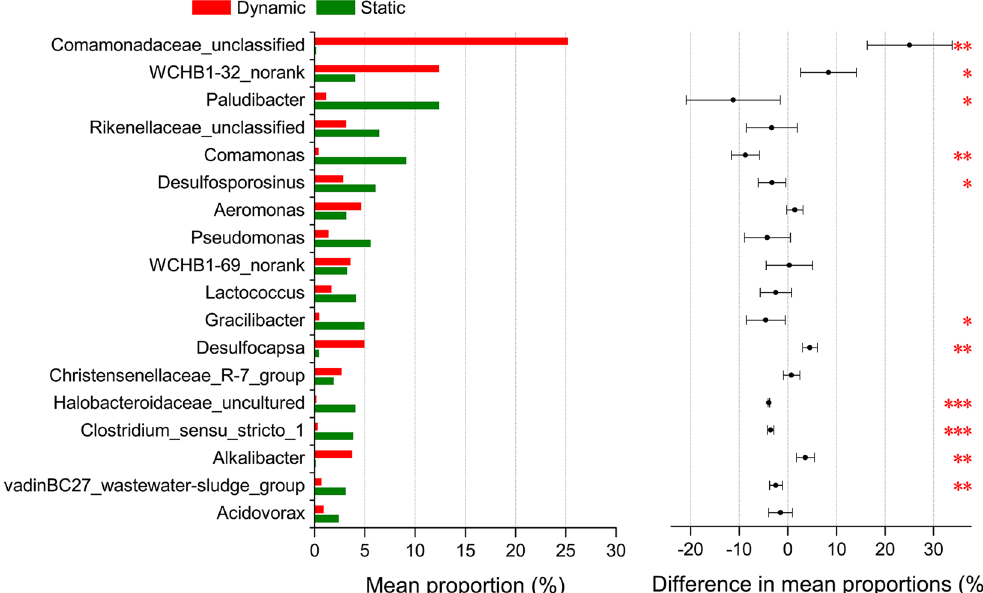
Figure 6. Chi-square test of the species abundance at the genus level for sediments under static and dynamic water flow conditions (0.01 < * p ≤ 0.05; 0.001 < ** p ≤ 0.01; *** p ≤ 0.001).